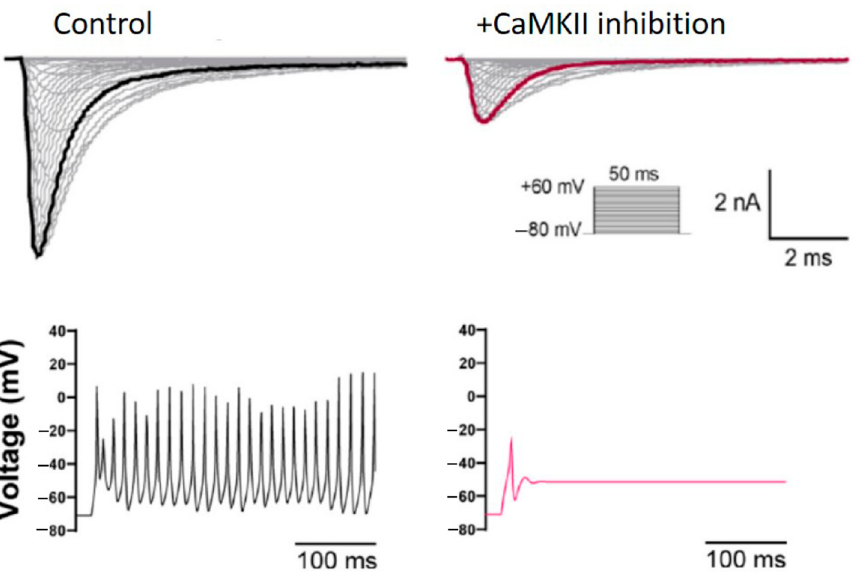
Figure 4. CaMKII modulates Na v 1.6 activity and neuronal excitability. CaMKII inhibition reduces Na v 1.6 sodium currents ( top ) and neuronal excitability ( bottom ) in simulated Purkinje neurons. This research was originally published in the Journal of Biological Chemistry [11], © the American Society for Biochemistry and Molecular Biology.